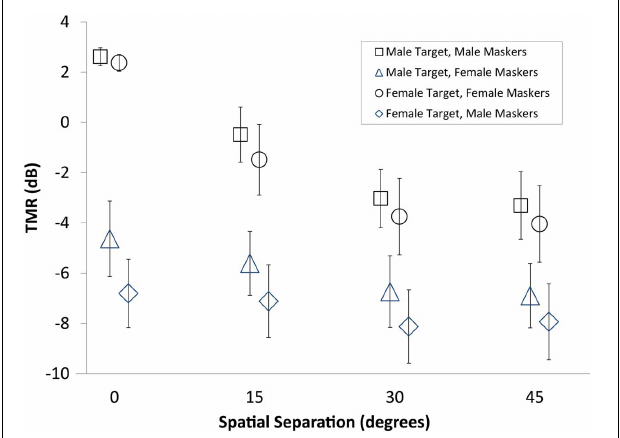
FIGURE 1 | Average thresholds for the subjects in Experiment One. Target-to-masker ratio (TMR) is plotted as a function of spatial separation between targets and maskers for male and female targets identified in the presence of male and female maskers. Spatial separation of 0 ◦ corresponds to colocated targets and maskers presented from the same